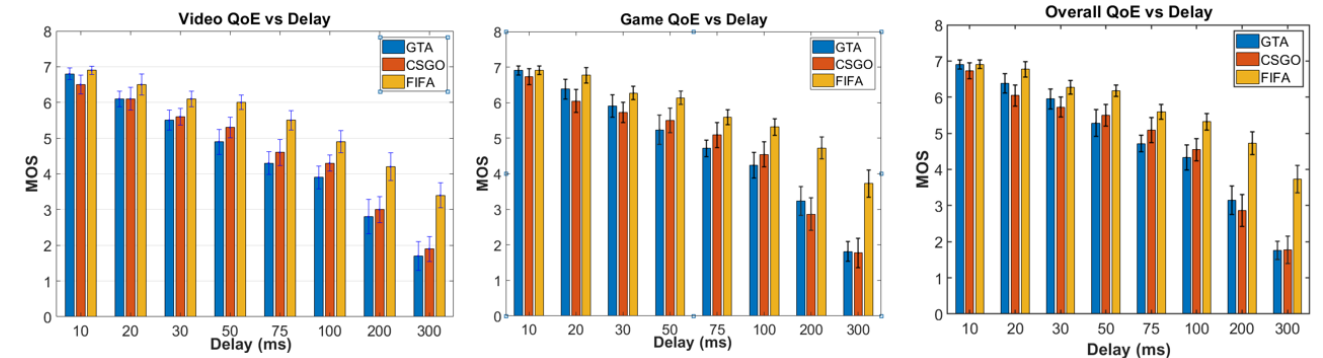
Figure 6. Different QoE dimensions against delay-only of